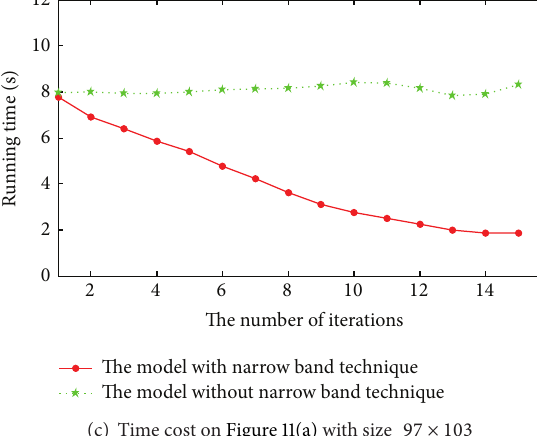
Figure 12: Time cost of the model with and without partition-based technique on three